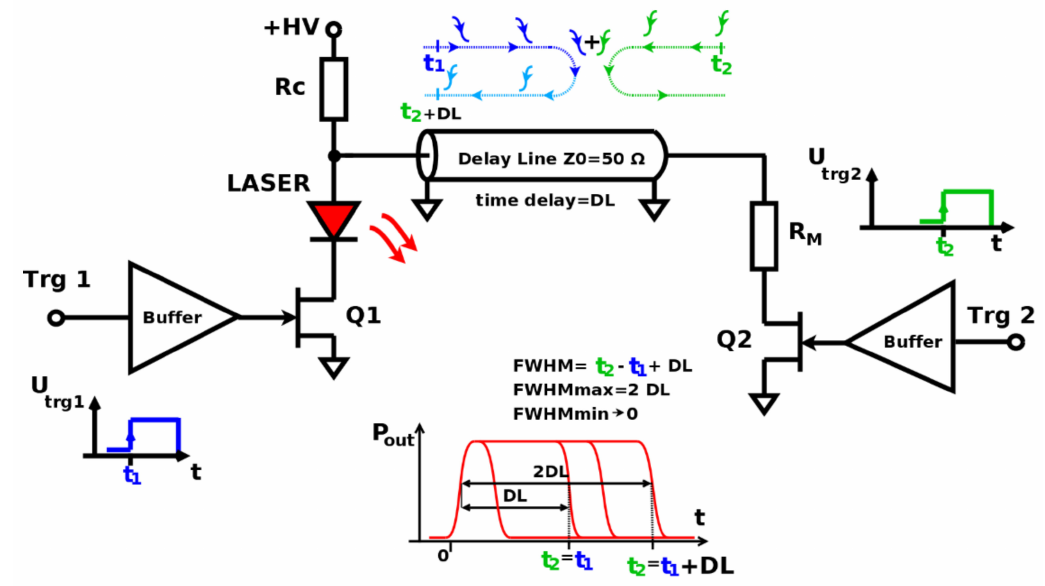
Figure 2. Simplified schematic of charge line dual-Field Effect Transistors (FET) laser diode